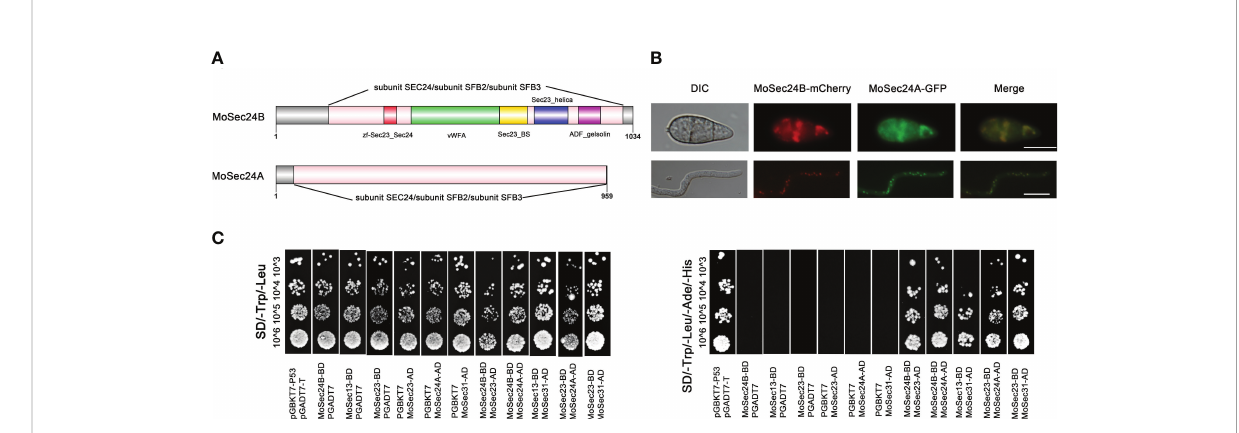
FIGURE 1 Identi fi cation of MoSec24 in M. oryzae and interactions within the COPII complex. (A) Structural domain analysis of the Sec24 homologous gene in M. oryzae . (B) Co-localization of MoSec24A-GFP and MoSec24B-mCherry in conidia and mycelium observed by fl uorescence microscopy images. Scale Bar = 10 m m. (C) Analysis of the interactions between different subunits within the COPII complex by yeast-two-hybrid.